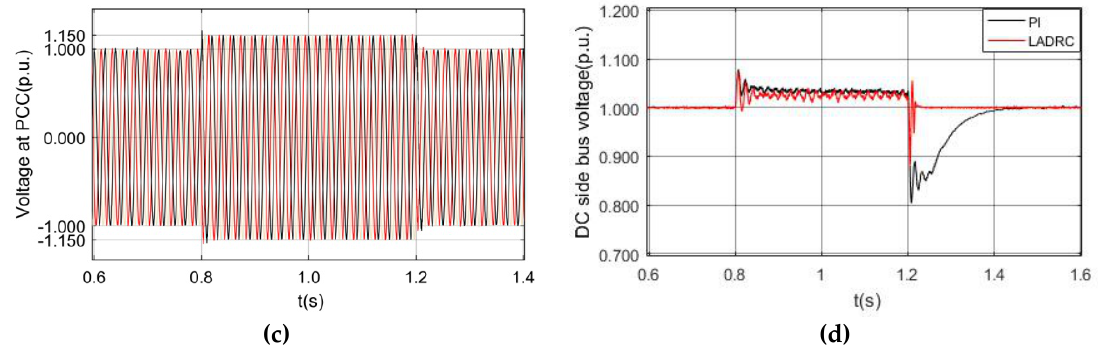
Figure 14. Dynamic response curve of DC bus voltage when grid-side voltage changes during PI double closed-loop control and LADRC dual-closed-loop control ( a ) grid-side voltage drops to 60% ( b ) Voltage waveform of DC side bus when voltage drops to 60% ( c ) grid-side voltage rises to 115% ( d ) Voltage waveform of DC side bus when voltage rises to 115%.